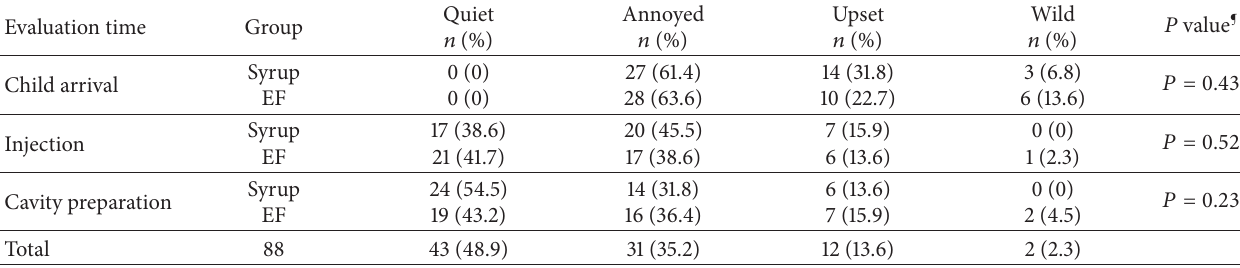
Table 2: Frequency of exhibited behavior according to North Carolina (NC) behavior rating scale.